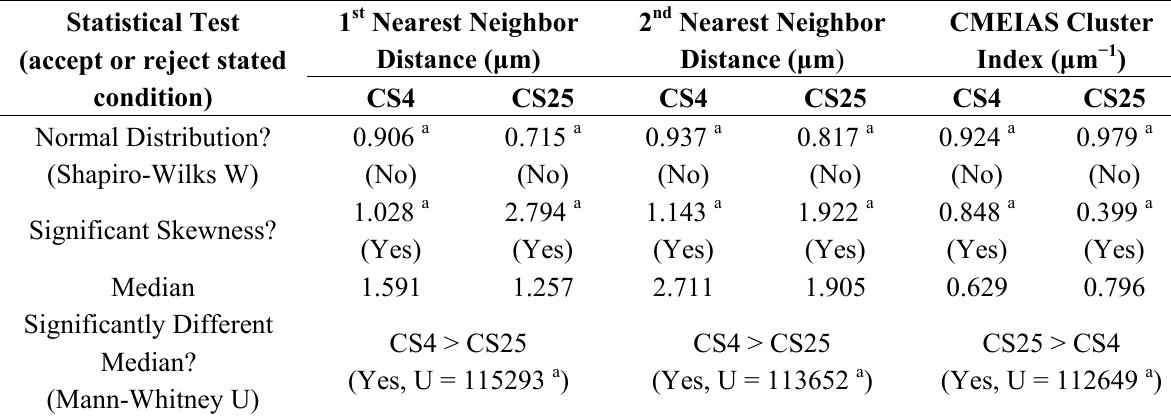
Table 1. Statistical inference tests of the distributions of nearest neighbor distances and clustered indices between individual bacteria within images of the CS4 and CS25 freshwater biofilm assemblages.